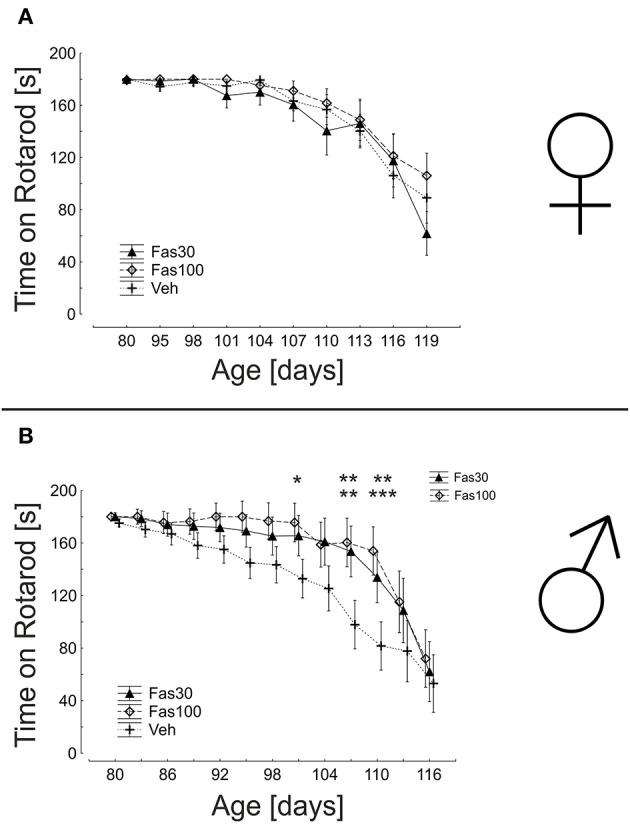
ROCK inhibition with Fasudil stabilizes motor performance in SOD1G93A male mice. Displayed are mean durations on the rotarod of female (Fas30 n = 14, Fas100 n = 15, Veh n = 14) (A) and male (Fas30 n = 11, Fas100 n = 12, Veh n = 12). (B) SOD1 G93A mice treated with 30 mg/kg Fasudil (Fas30), 100 mg/kg Fasudil (Fas100), or with vehicle (Veh). Data represent means ± SEM. *
P < 0.05; **P < 0.01, ***P < 0.001.